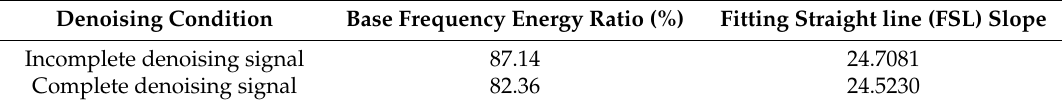
Figure 4. Incompletely denoised signal and fully denoised signal FSL comparison chart. Table 2. Incomplete denoising signal and complete denoising signal characteristics comparison.